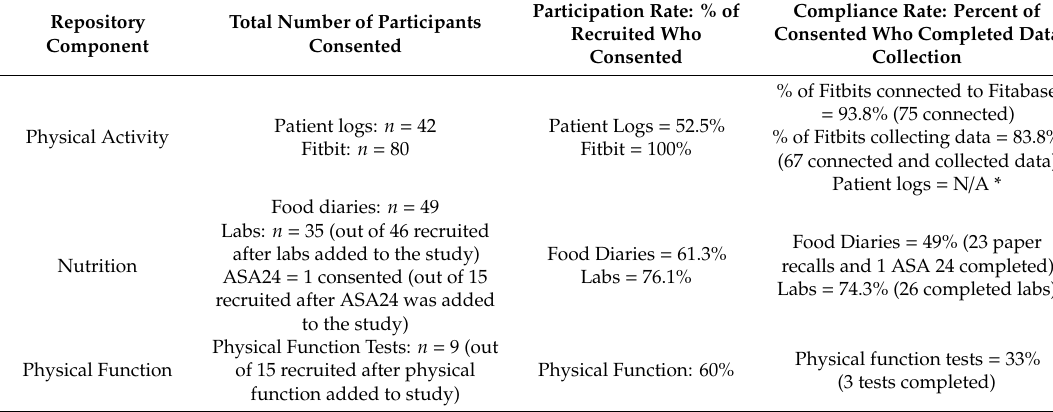
Table 3. Acceptability: participation rate and the completion of data